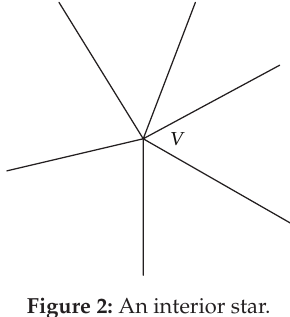
Figure 2: An interior star.